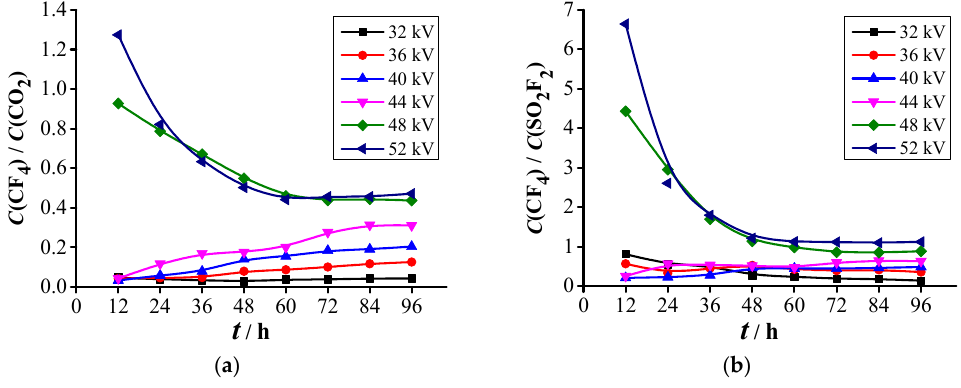
Figure 10. Change of concentration ratios with time: ( a ) C (CF 4 )/ C (CO 2 ); and ( b ) C (CF 4 )/ C (SO 2 F 2 ). The feature sorting of the concentrations and concentration ratios of SF 6 decomposed components for the PD severity diagnosis is conducted based on the principles of MID and MIQ, respectively. The feature order is shown in Table 4, and the concentration ratios in the table are indicated by their corresponding labels. The first two features, namely, CF 4 and SOF 2 , of the concentrations are the same, and the first four features, namely, C (CO 2 )/ CT 1 , C (CF 4 )/ C (SO 2 ),